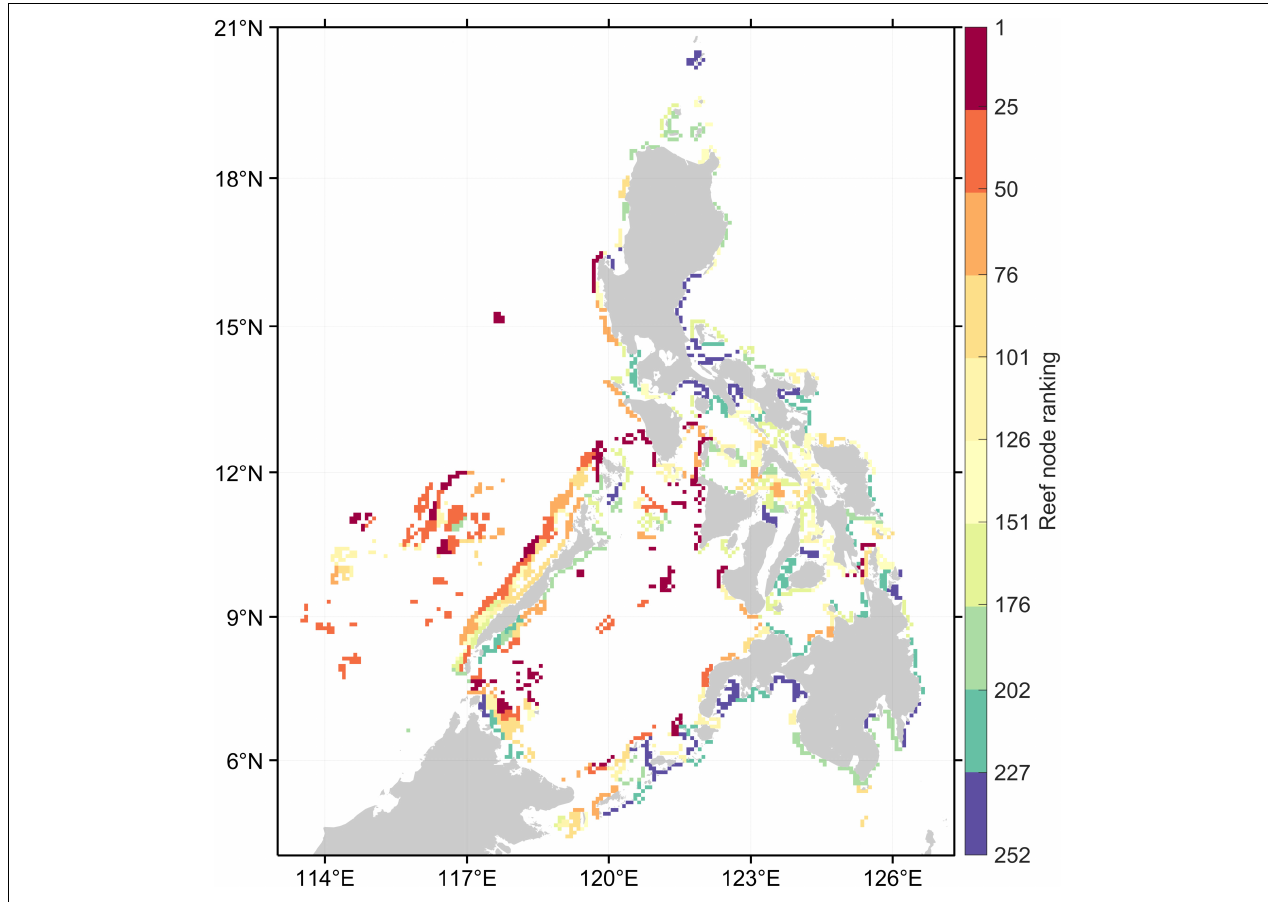
FIGURE 2 | Overall ranking of reef nodes based on the average ranking across organisms and four connectivity indices. Warm colors represent the top reef nodes that generally ranked high in most connectivity indices. Reef nodes in red are the top 10% while in purple are the bottom